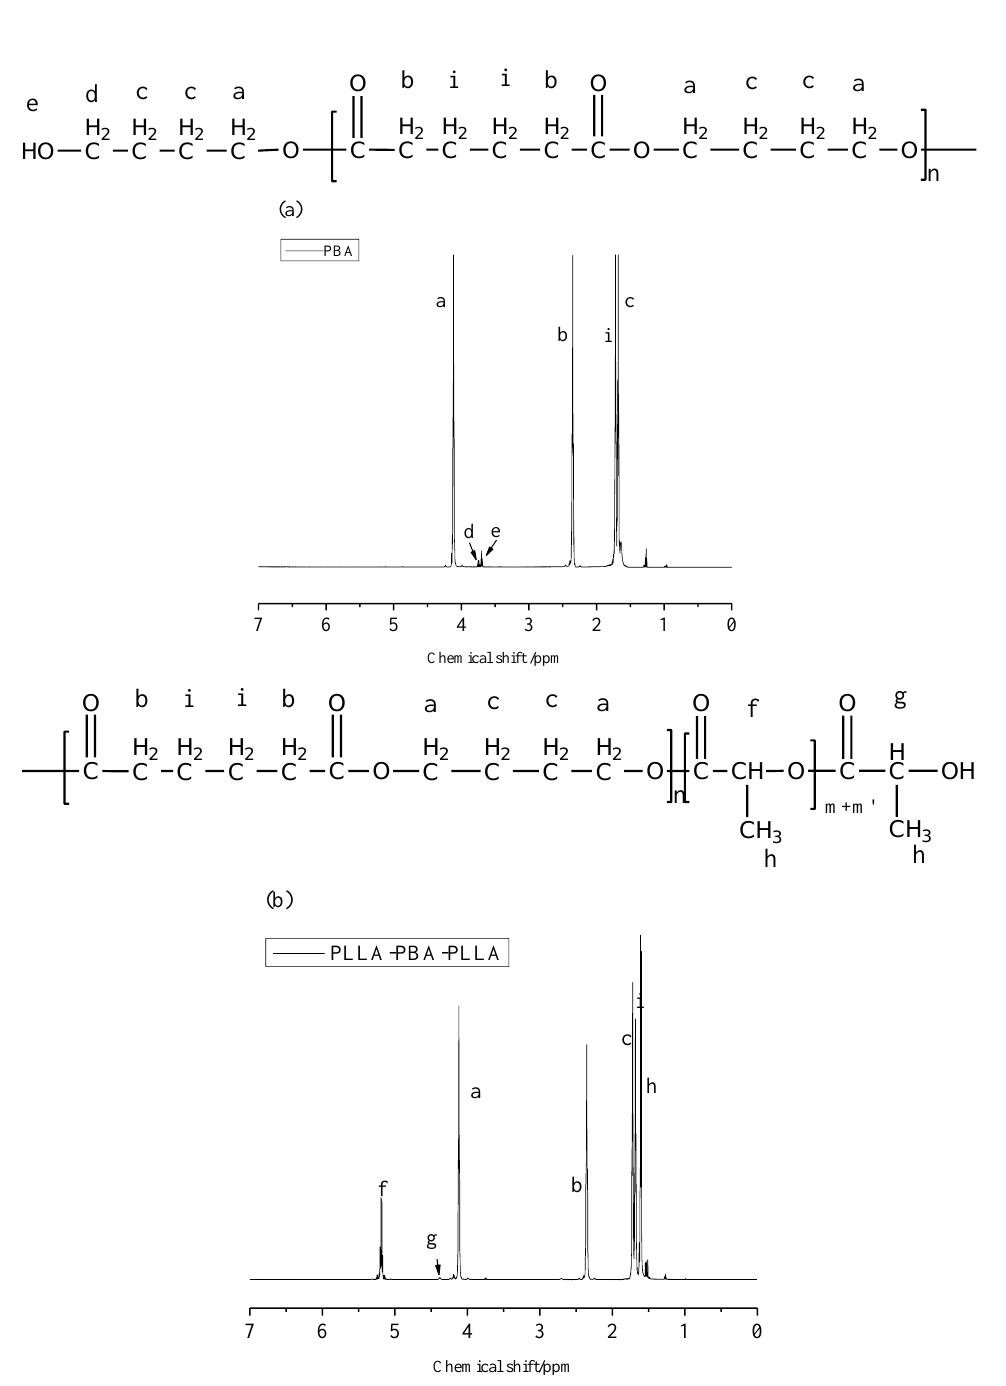
Figure 2. 1 HNMR spectra of ( a ) PBA and ( b ) PLLA-PBA-PLLA